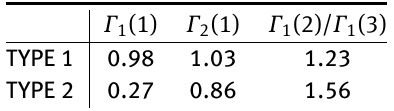
Table 1: Comparison of inclusion regions based on eigenvalues.